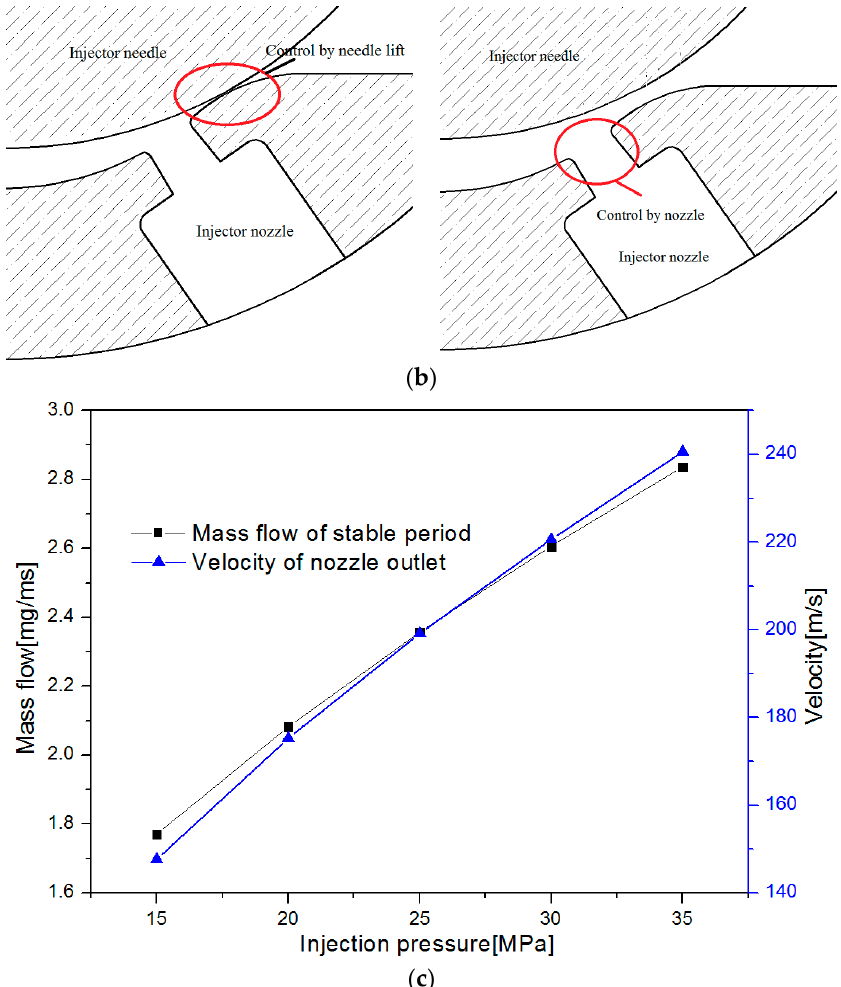
Figure 6. The effect of injection pressure on the injection characteristic. ( a ) The effect of injection pressure on the injection law, ( b ) Control of minimum flow section area, ( c ) The influence of injection pressure on the injection velocity.